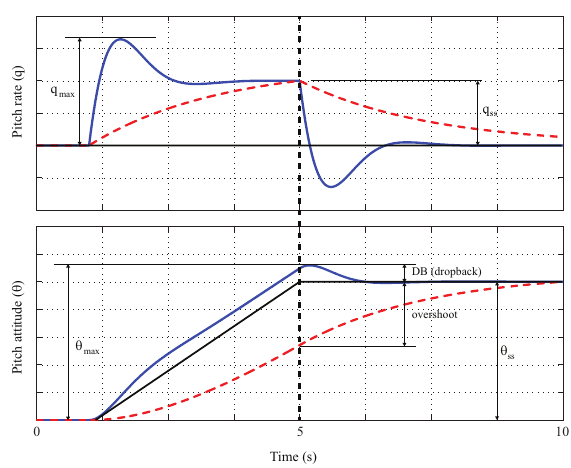
Fig. 10. Visualisation of q max , q ss and DB terms used in the Gibson Dropback criterion